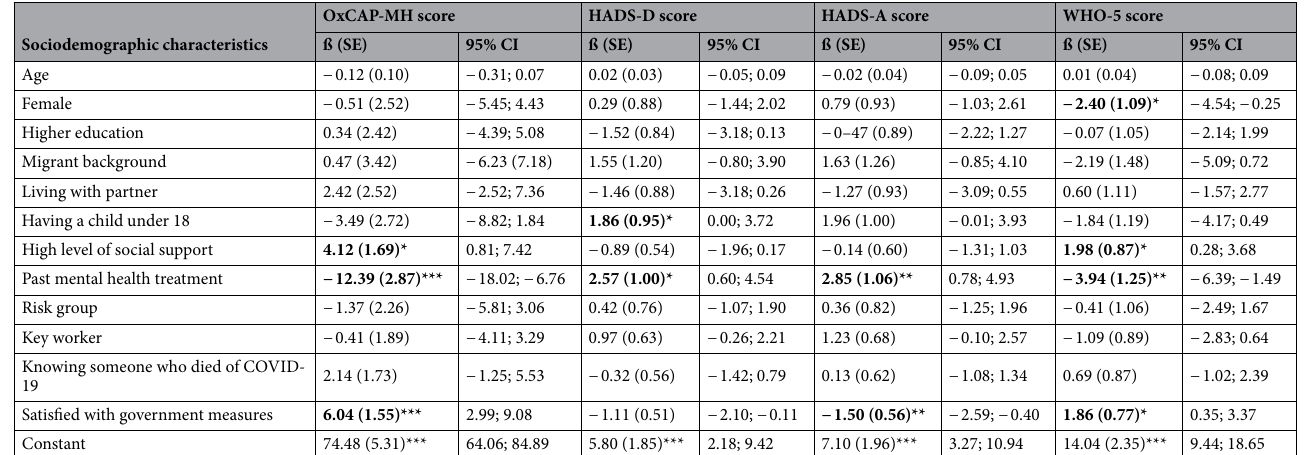
Table 2. Associations between capability wellbeing, depression, anxiety, and general wellbeing across the three lockdowns by sociodemographic characteristics (n = 87). Standard errors (SE) in parentheses * p < 0.05, ** p < 0.01, *** p < 0.001; Statistically significant coefficients (p < 0.05) in bold. OxCAP-MH Oxford CAPabilities questionnaire-Mental Health, HADS-D Hospital Anxiety and Depression Scale Depression subscale, HADS-A Hospital Anxiety and Depression Scale Anxiety subscale, WHO-5 World Health Organisation-Five Well-being Index; Level of social support was based on MSPSS score (scores ranging from 1 to 5 were categorised as moderate to low level of support; whilst scores from 5.1 to 7 could be considered high level of